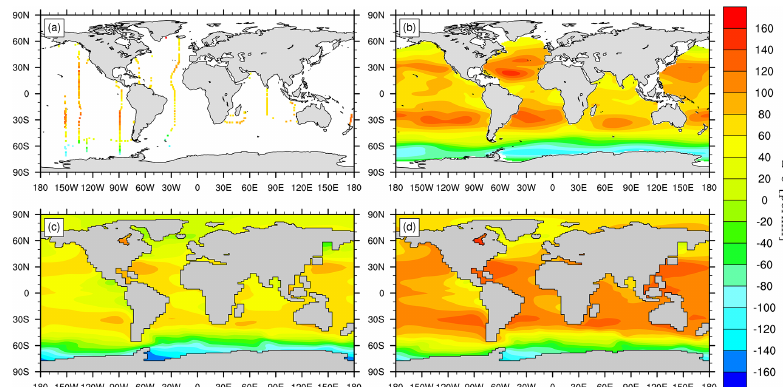
Figure 2. Surface values of total (cid:49) 14 C from the 1990s (including bomb 14 C) from (a) cruise data compiled by Schmittner et al. (2013), (b) the gridded GLODAP data (Key et al., 2004), (c) simulated biotic (cid:49) 14 C, and (d) simulated abiotic (cid:49) 14